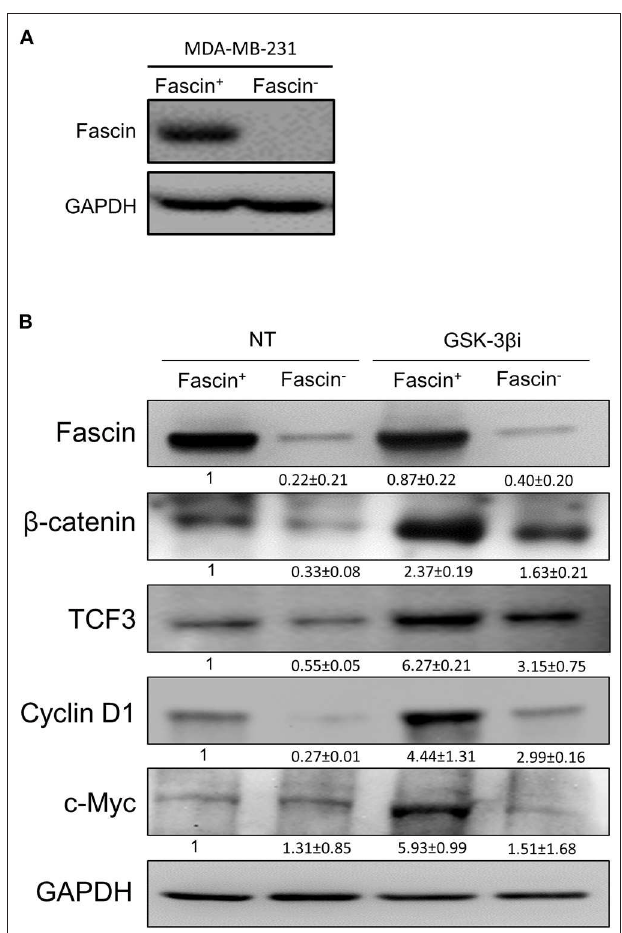
FIGURE 1 | (A,B) Fascin knockdown reduces the expression of β -catenin and its downstream targets in breast cancer cells. (A) Western blot image showing fascin expression after its knockdown (fascin − ) in MDA-MB-231 cells. (B) Western blot images showing the expression levels of fascin, β -catenin, TCF3, cyclin D1, and c-Myc following fascin knockdown in MDA-MB-231 cells before and after treatment with GSK-3 β i. The expression of each protein was normalized on GAPDH, and the numbers shown below the images indicate the mean fold changes (of three independent experiments ± SD) in fascin − in reference to fascin + group or in GSK-3 β i–treated fascin + and fascin − cells in reference to their respective untreated